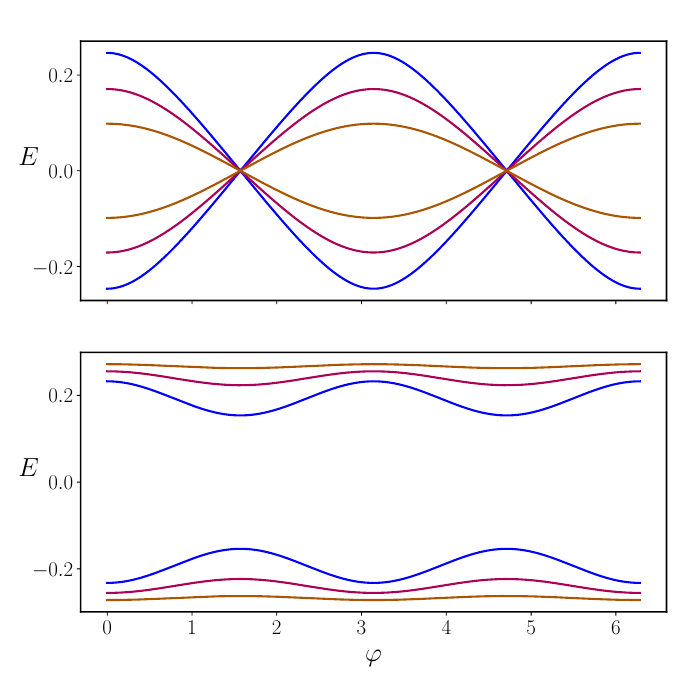
= 1.25 (blue), 2.5 (red) and 5 N